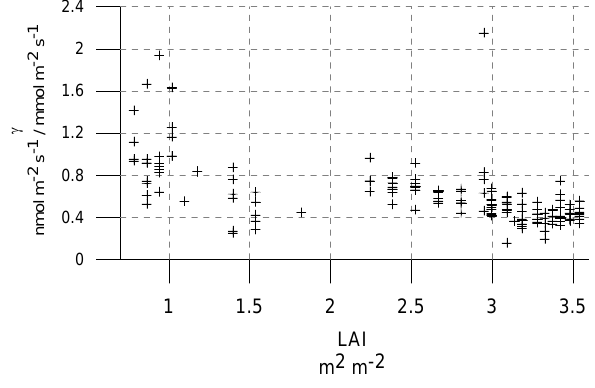
Fig. 11. γ versus LAI of the intensive field for the period 02.07–